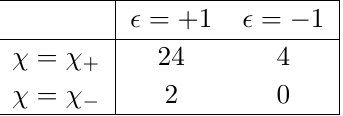
Table 1 . The number of Z 2 × Z 2 self-dual SPT phases without time-reversal symmetry.